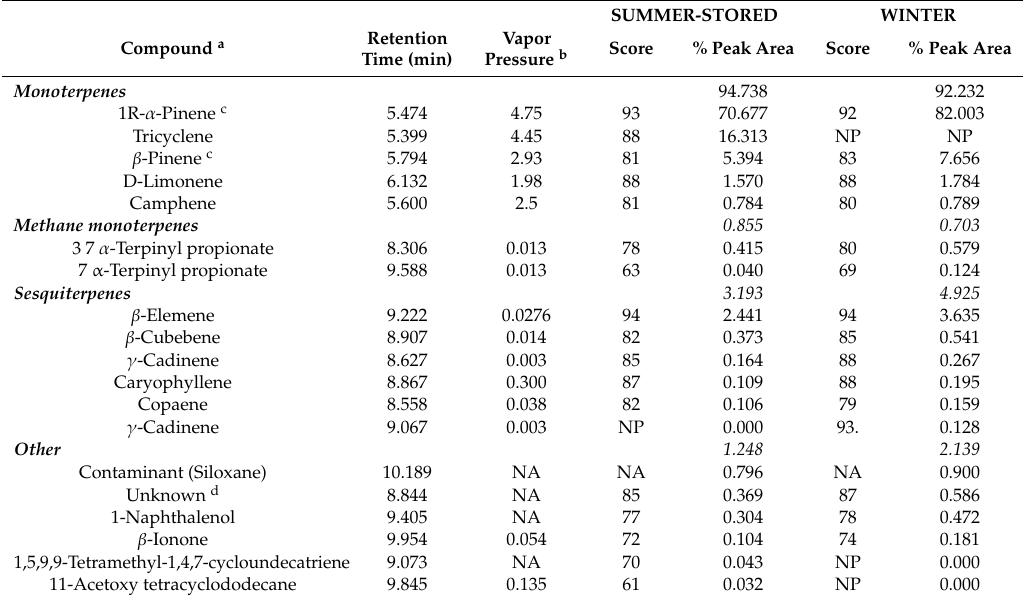
Table 1. Volatile components of Sciadopitys verticillata resins analyzed by gas chromatography / mass spectrometry (GC /